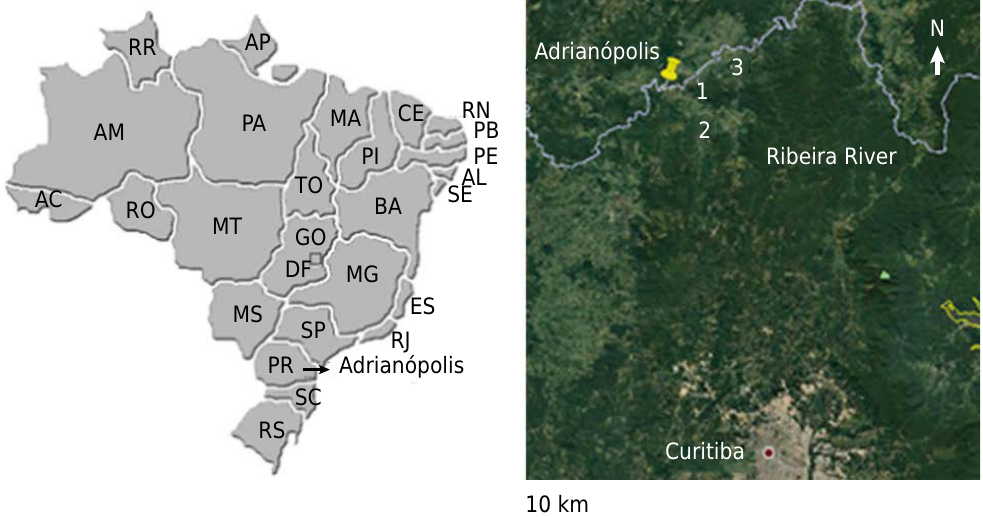
Figure 1. Map of Brazil with the municipality of Adrianópolis (Paraná - PR) and the positions of the three areas studied. The UTM coordinates of areas 1 to 3 are in table